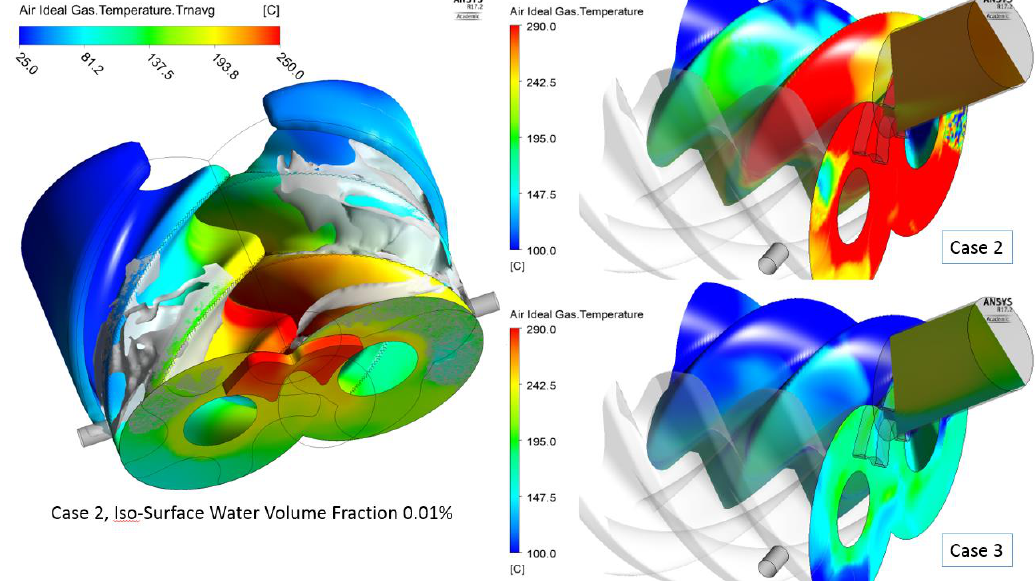
Figure 14. Iso-surface of liquid water and cycle averaged air temperature distribution.